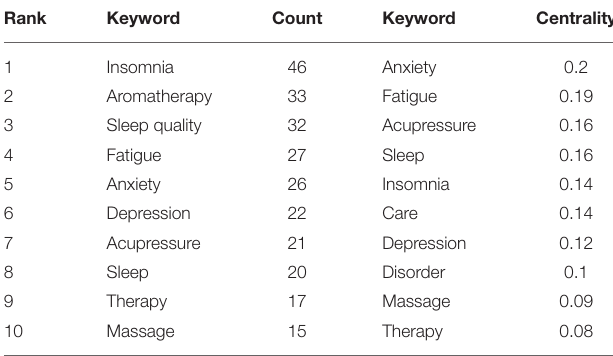
TABLE 6 | Top 10 key words in terms of frequency and